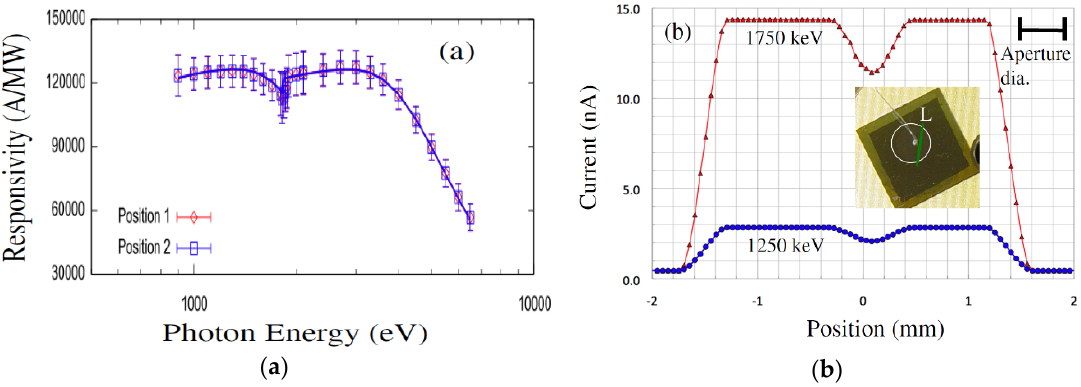
Figure 11. ( a ) Responsivity of the detectors on 4H-SiC n-type epitaxial layer at two different locations and ( b ) surface scan profiles along line L obtained to assess the detector’s